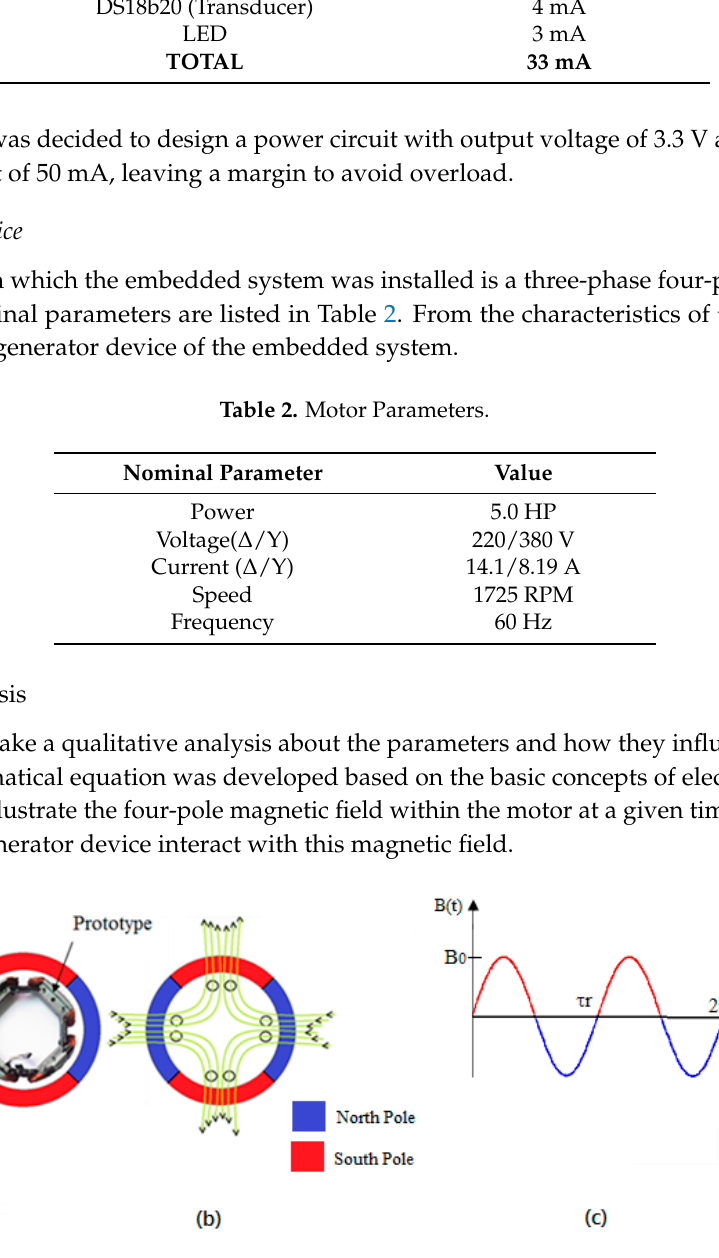
Figure 5. Arrangement of the generator coils in relation to the four poles generated by the stator. ( a ) Physical device; ( b ) simplified representation; ( c ) stator magnetic flux wave form.